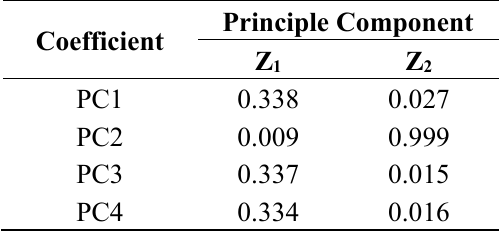
Table 9. The weight factor matrix of principle